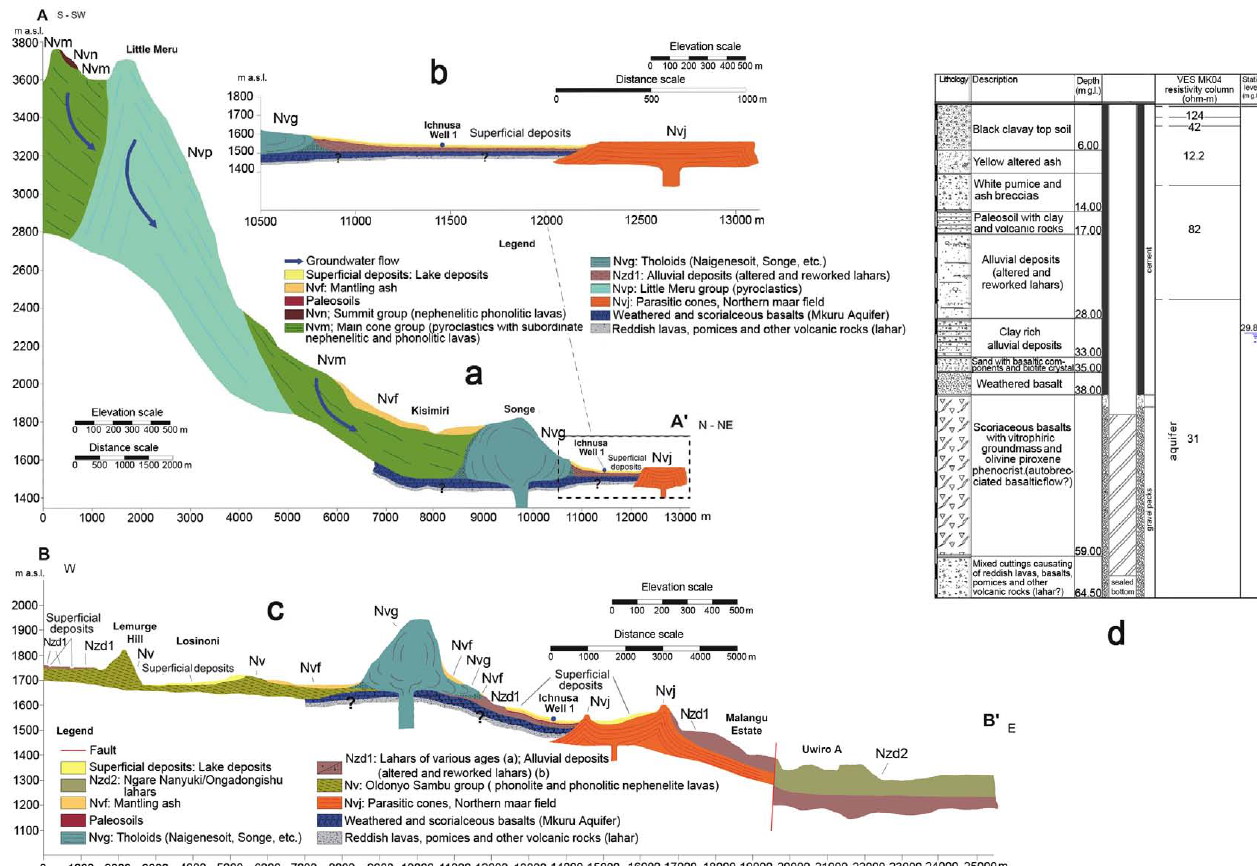
Fig. 6. (a) Geological-hydrogeological cross section A-A 0 (vertical magnification factor ∼ × 4). (b) Detail of the area surrounding the Ichnusa Well 1. (c) Geological-hydrogeological cross section B-B 0 (vertical magnification factor ∼× 7). (d) The Ichnusa Well 1: lithological log and well construction report. This shows a comparison between the stratigraphy and the resistivity column of the electrical sounding